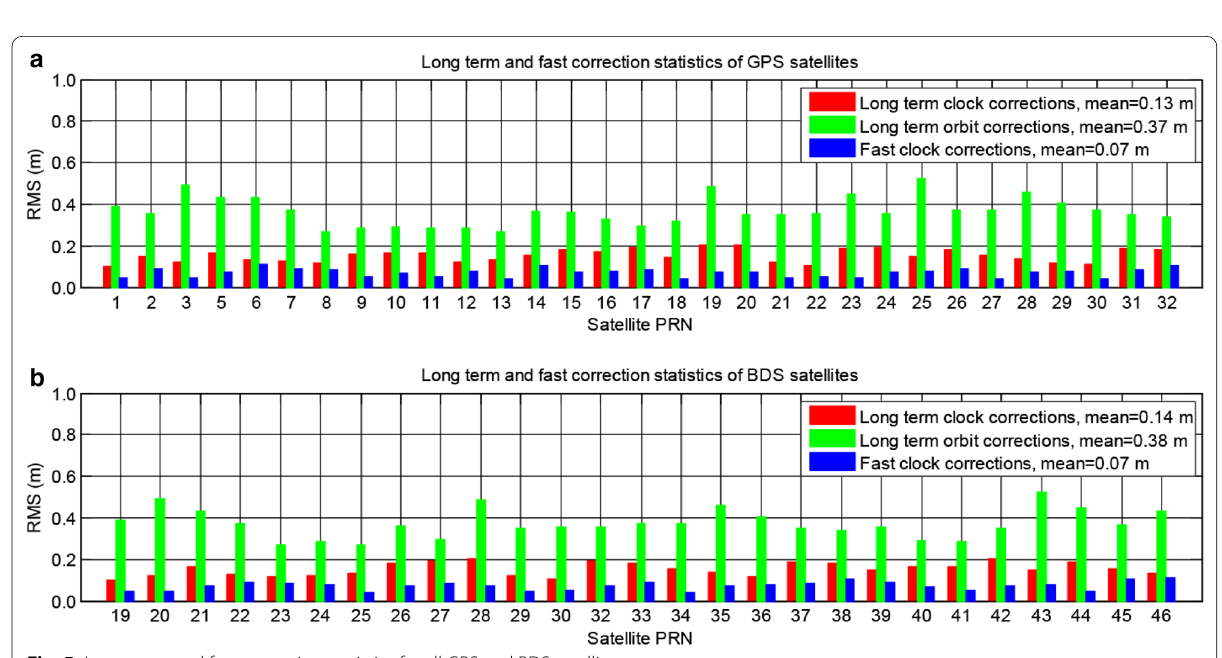
Fig. 5 Long-term and fast correction statistics for all GPS and BDS